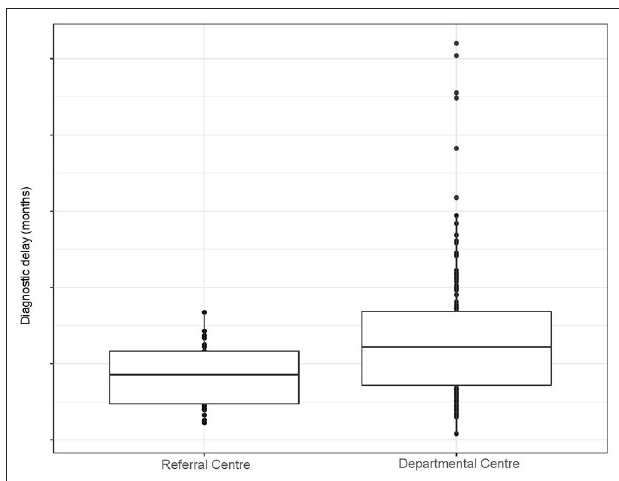
FIGURE 2 | Boxplot representing the diagnostic delay in the referral and departmental centers.